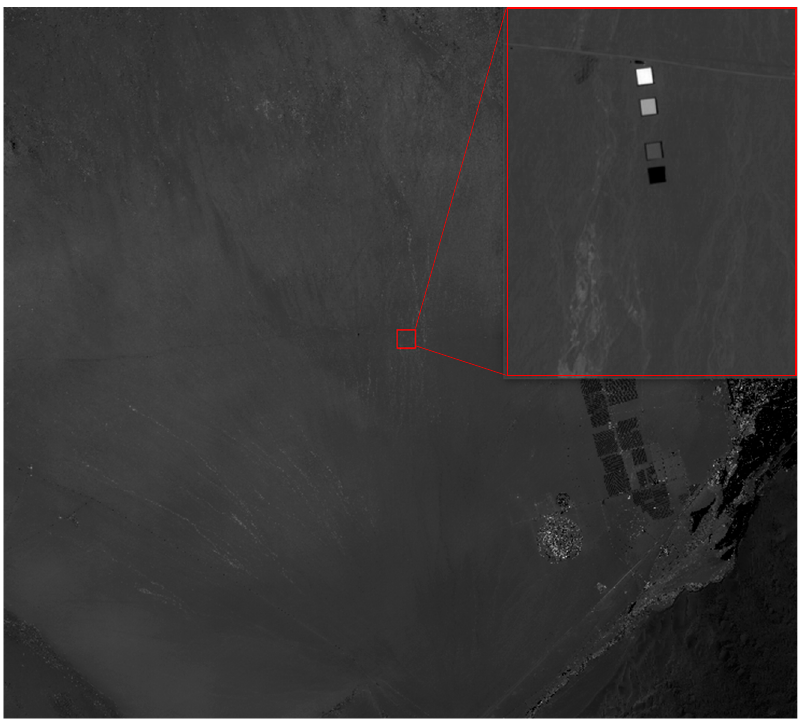
Figure 5. Multispectral image of the target area on 18 August 2018 (band 1).